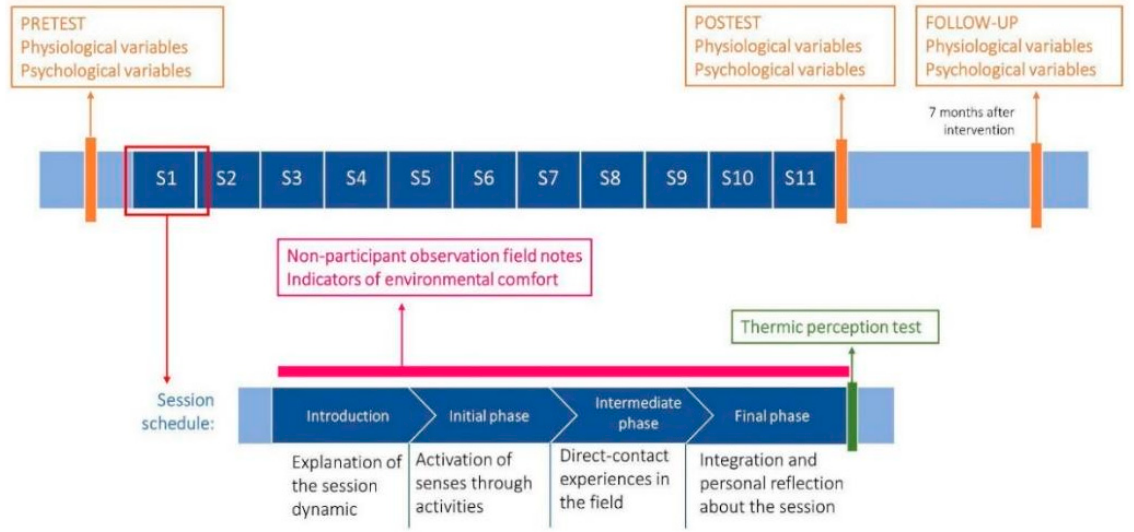
Figure 2. Intervention and data collection schedule. FTHub sequence selected for this